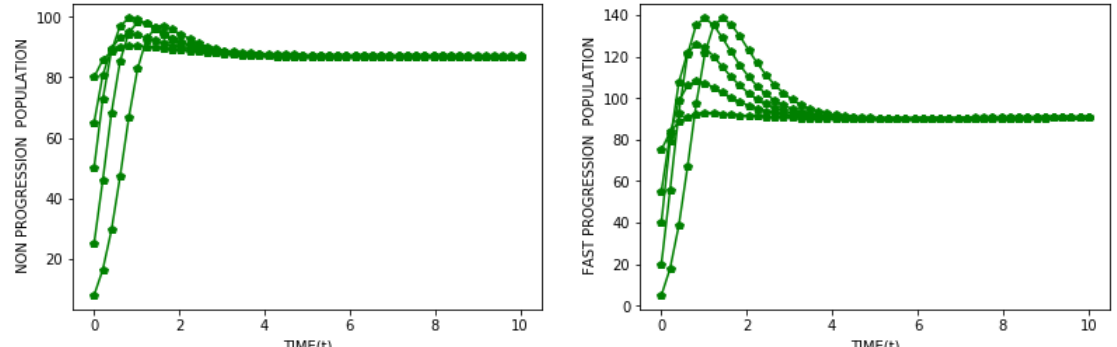
Fig. 10 and Fig. 11 Showing The Behavior of Both Non Progression and Fast Progression Populations when R T is Greater Than Unity.